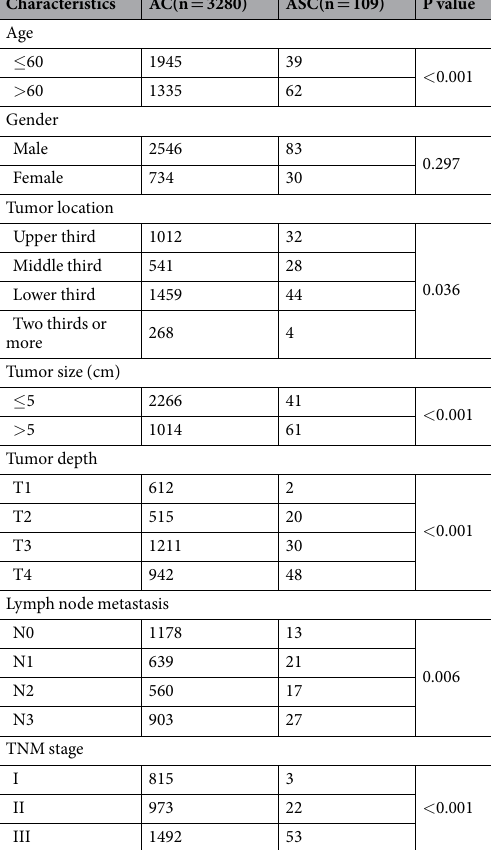
Table 3. Comparison of selected clinicopathological parameters between gastric AC and ASC patients underwent R0 resection.